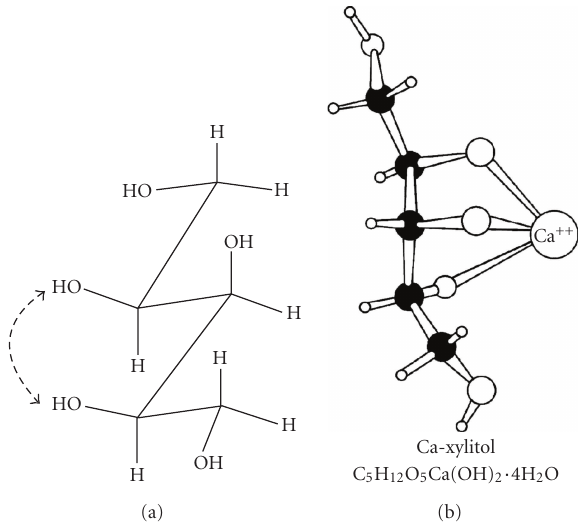
Figure 4: The zigzag structure of xylitol (a) and that of a xylitol- Ca complex (b) assumed to exist also in salivary environments and generally under physiologic conditions in the human body. The double-headed arrow in (a) reflects the special interaction between the oxygen atoms shown. The complex formation can facilitate the transport of Ca through membrane pores and also against weak Ca gradients. This structure may aid in the transport of Ca through the gut